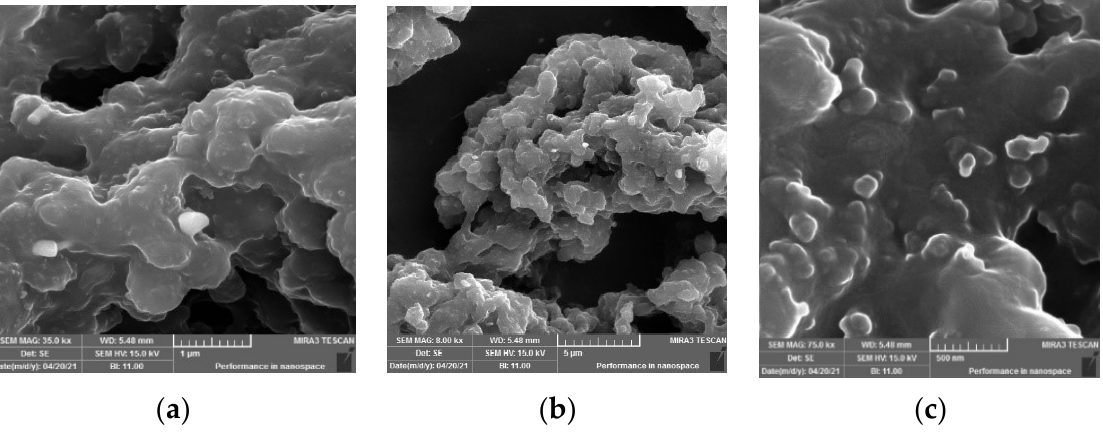
Figure 5. SEM images with different magnifications ( a ) 35k, ( b ) 8k, ( c ) 75k of original scrap tire sample. The SEM image (Figure 5c) shows that the sample is in an elastic form with small par- ticles distributed in and between the folds in clusters and is a carbon black nano composite. The Brunauer − Emmett − Teller (BET) measurements of the original scrap tire (Table 3) show the specific surface area of the particles. The Langmuir plot describes the total amount of nitrogen gas bond to the particles’ surfaces at a specific temperature and at a pressure of 1.7959 m 2 /g. The t plot provides information on the multilayer formation of the micropores; the micropore surface area (0.2705 m 2 /g) was calculated from the difference between the BET area and the external surface area. Finally, the BJH plot (Table 3) yields the pore area of 3.09 nm and the specific surface area of 1.2749 cm 2